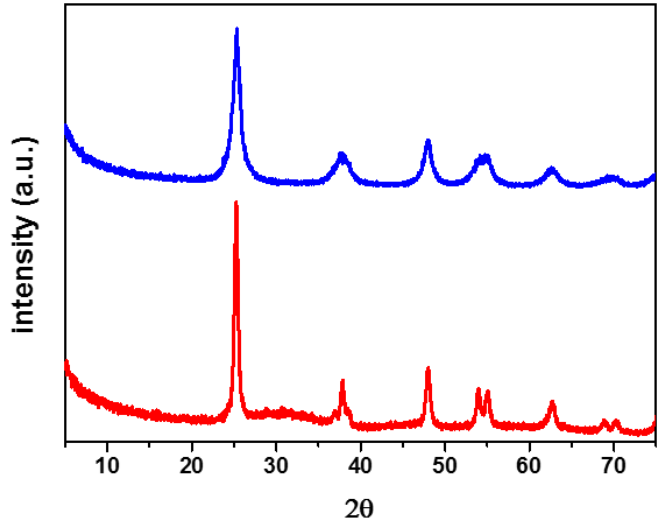
Figure 5. XRD patterns of unpromoted TiO 2 (red curve) and commercial sample (blue curve).